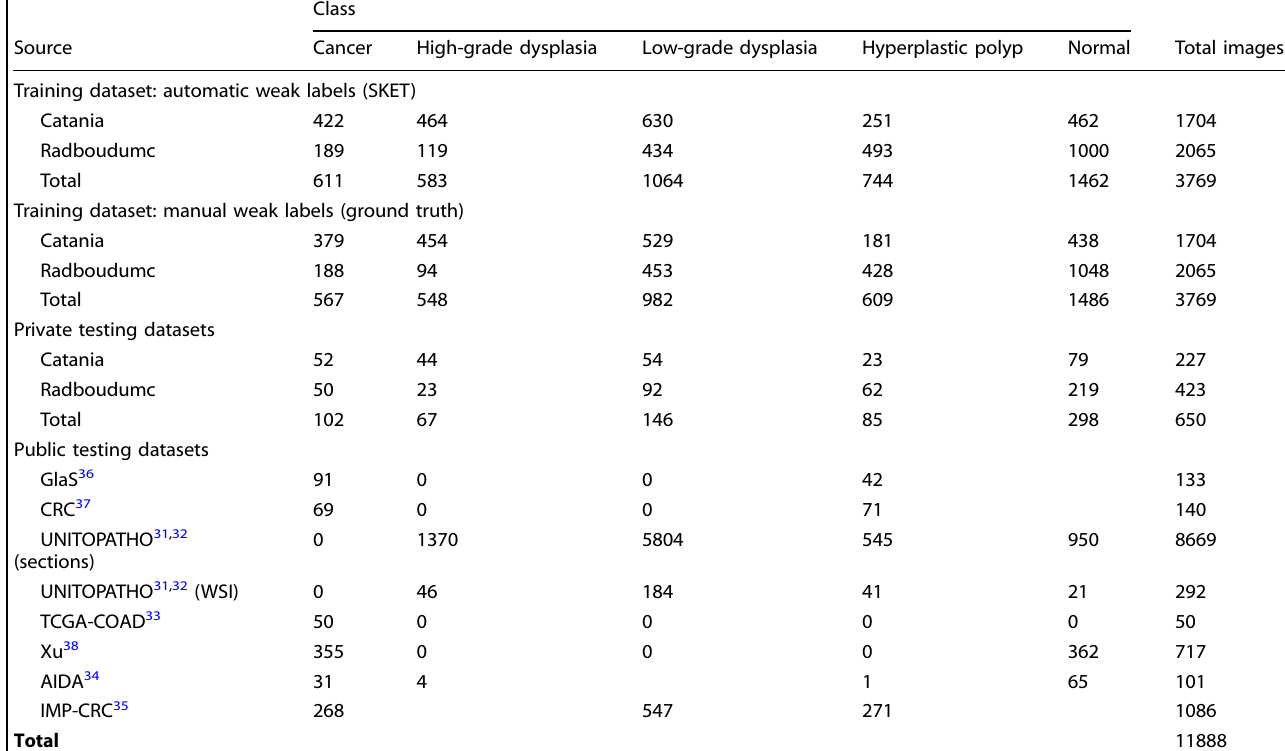
Table 1. Overview of the dataset composition.